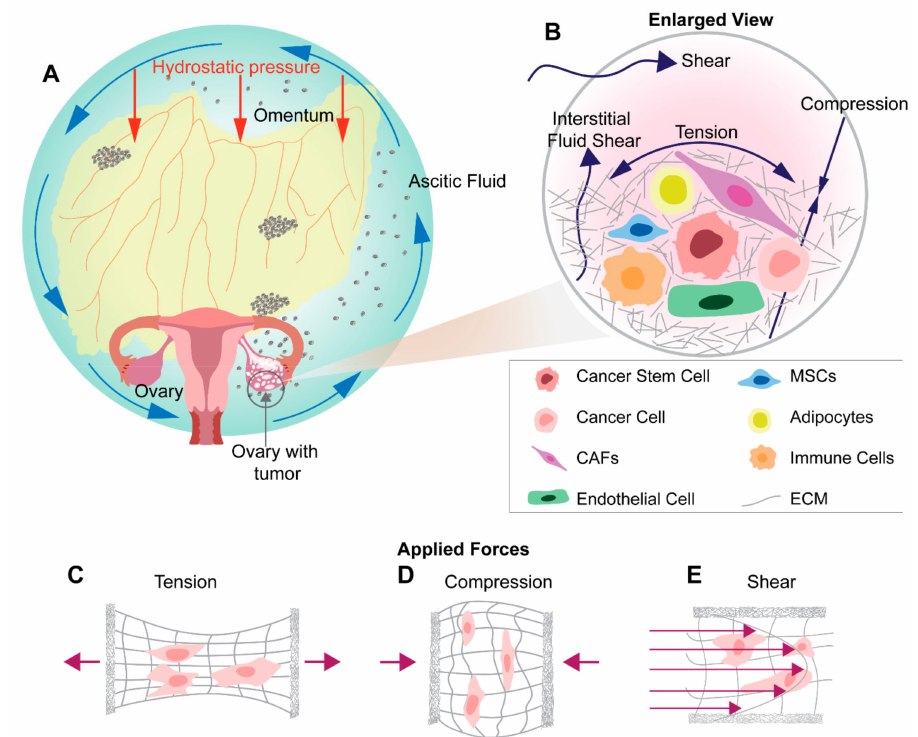
Figure 1. Mechanical and cellular regulators of ovarian cancer metastasis. Ovarian cancer progression and metastasis are driven by chronic exposure to mechanical stimuli and tumor supporting cells. ( A ) Increased fluid movement within the pathological ovarian tumor microenvironment exposes ovarian cancer cells to high levels of shear stress. The aforementioned environment is caused by a combination of normal body function and ascitic buildup within the peritoneal cavity. Teal circle indicates the peritoneal cavity, blue arrows indicate interstitial fluid flow and red arrows indicate hydrostatic pressure. ( B ) Zoomed in view of the cellular makeup of the tumor microenvironment, which is composed of cancer stem-like cells, cancer cells, cancer-associated fibroblasts (CAFs), endothelial cells, mesenchymal cells (MSCs), adipocytes and immune cells, that interact to influence tumor progression and metastasis. Neoplastic growth steadily increases tumor size providing radial tension and axial compression to ovarian cancer cells. E ff ects of ( C ) tension, ( D ) compression and ( E ) shear stresses on cancer cells within the ovarian tumor